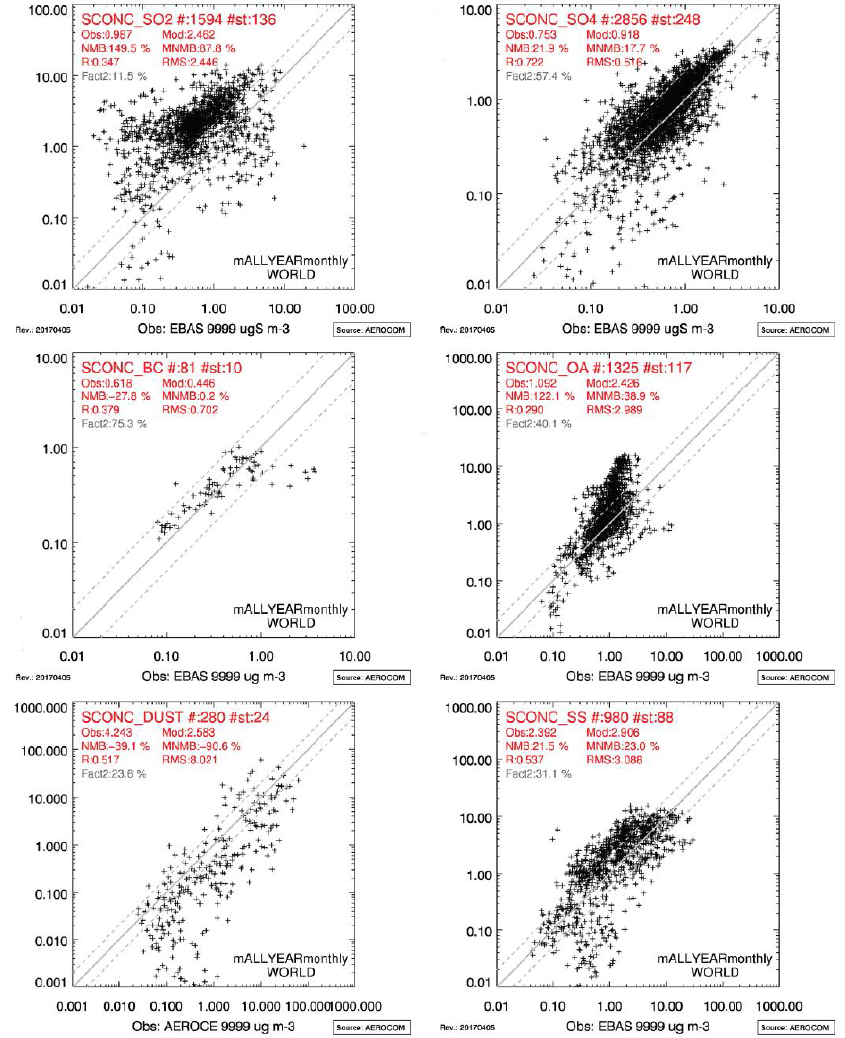
Figure 6. Surface concentrations in the NUDGE_PD experiment compared with EBAS and AEROCE data through the AeroCom tools. OA represents modeled OM concentrations vs. observed OC concentrations multiplied by 1.4 (the assumed OM / OC ratio for fossil fuel OC in the